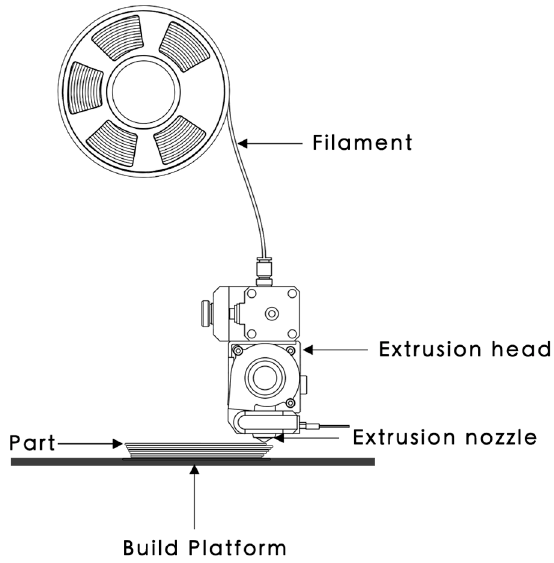
Figure 1. The material extrusion (ME) process.